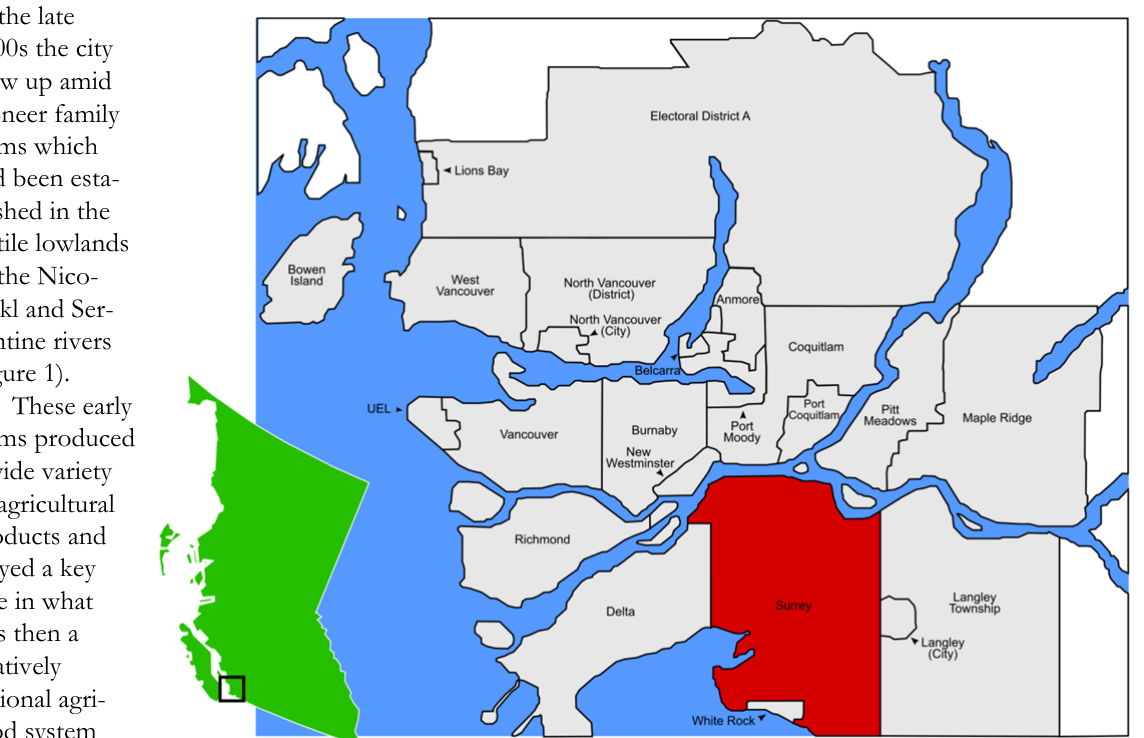
Figure 1. Metro Vancouver, B.C., with City of Surrey